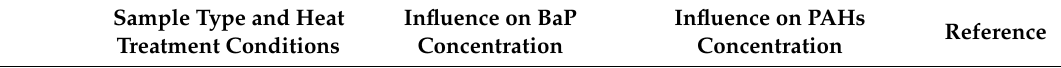
Table 3. Influence of marinating and spices or natural plant additives on PAH concentrations in cooked meat. Concentration changes are presented as given in the publications, i.e., in % or